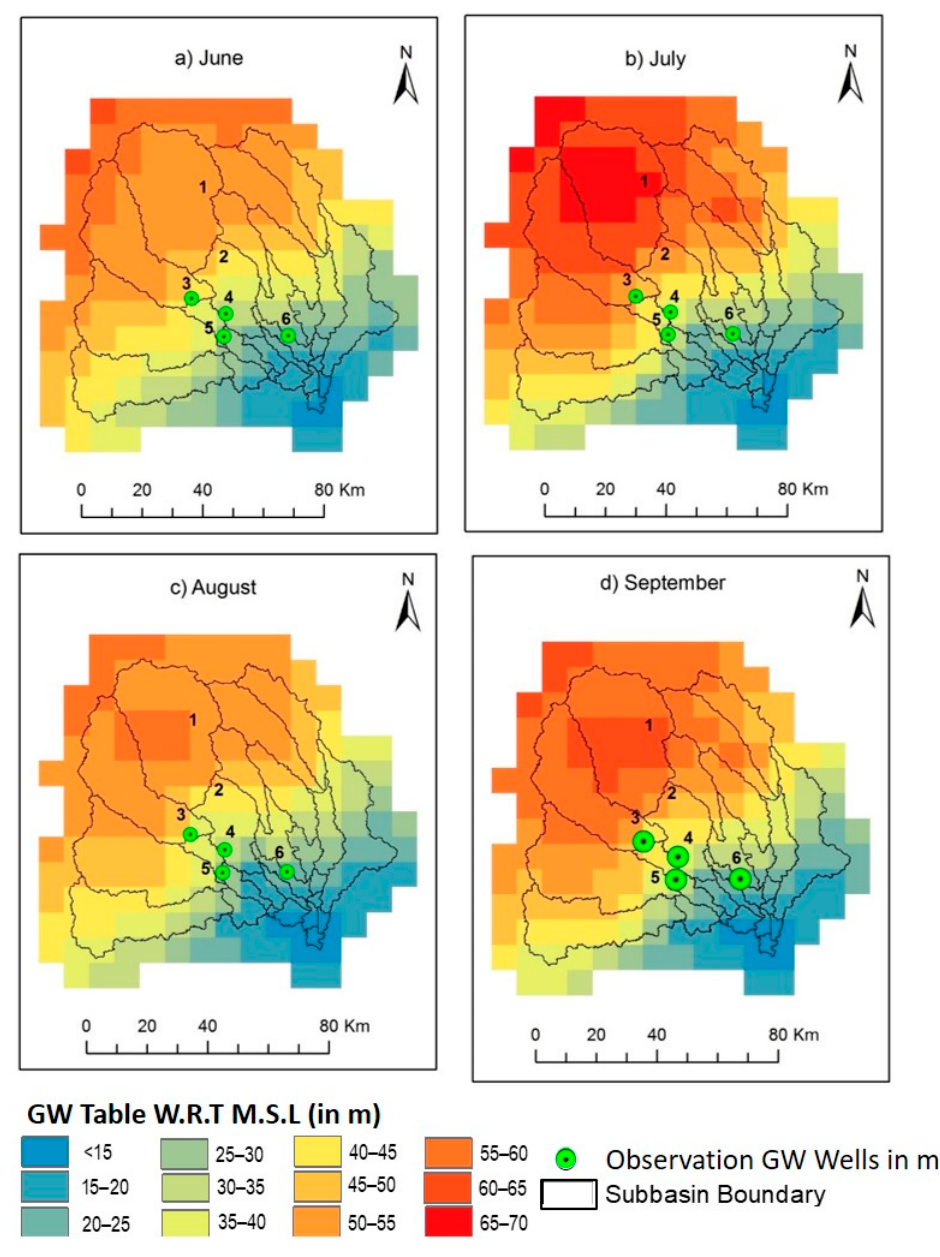
Figure 10. Simulated Spatial Distribution of GW head (w.r.t MSL, in m) by SWATAEM.